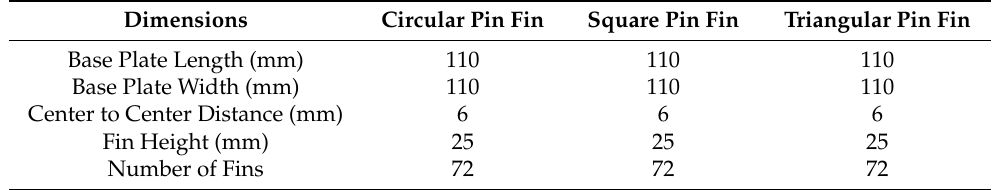
Table 2. Heat sink